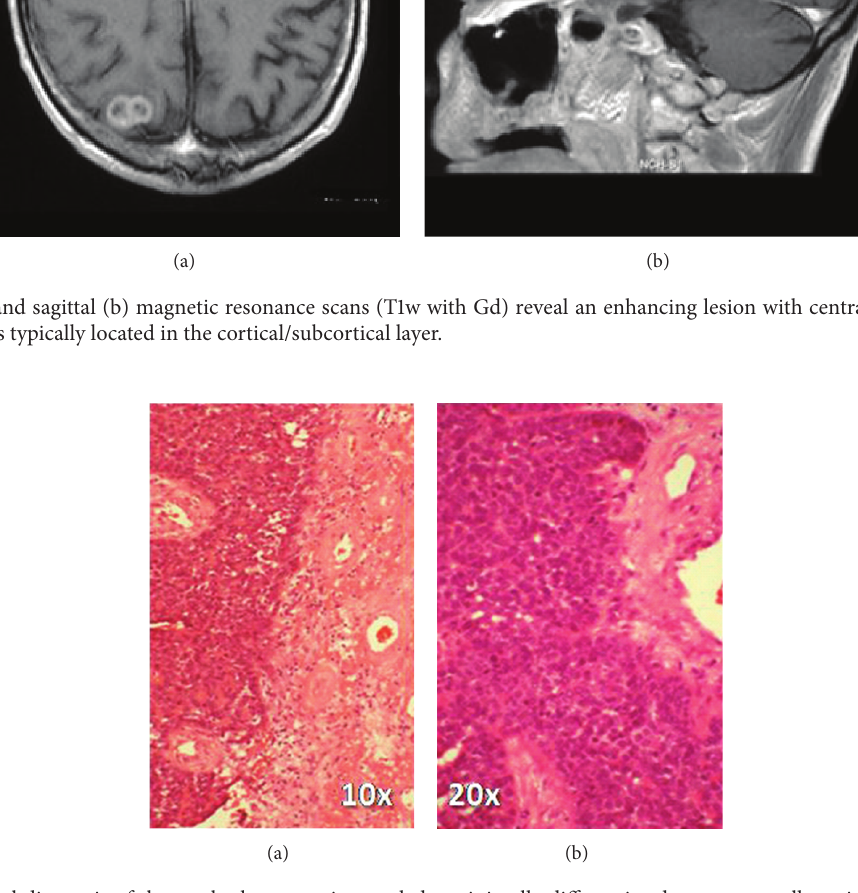
Figure 2: Histological diagnosis of the cerebral metastasis revealed a minimally differentiated squamous cell carcinoma with single horn pearls, solid growth, pleomorphic nuclei, and numerous mitosis, adjacent to edematous brain tissue with extensive reactive gliosis. H and E